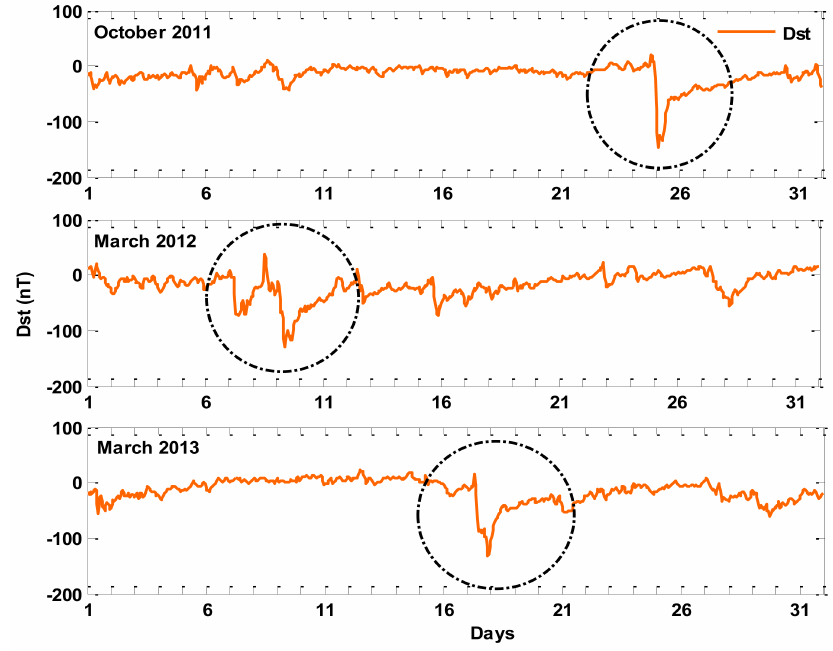
Figure 6. The variations of the Dst index in October 2011, March 2012, and March